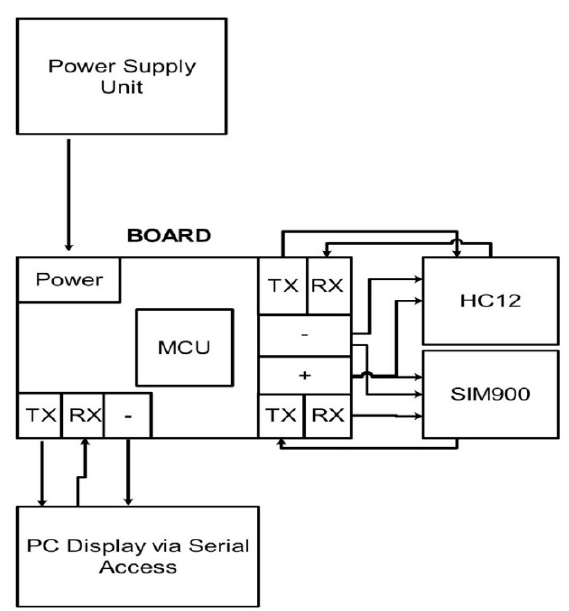
Figure 4. Hardware design of gateway node.